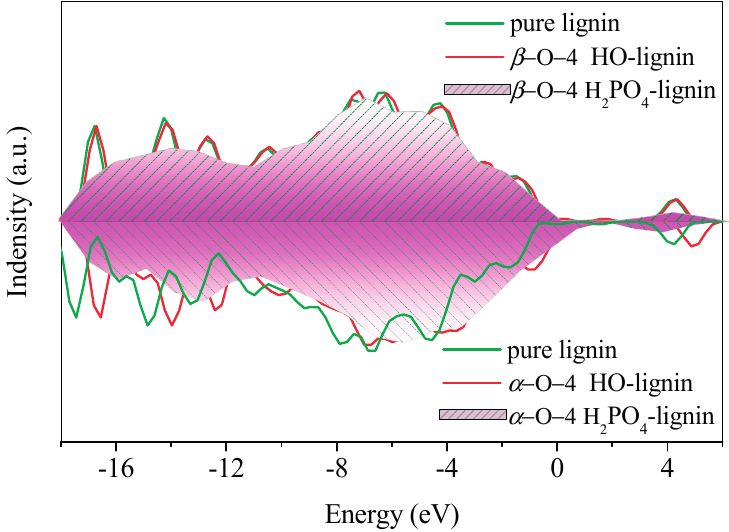
Figure 5. DOS for the pure lignin, HO-functionalized lignin, and the H 2 PO 4 -functionalized